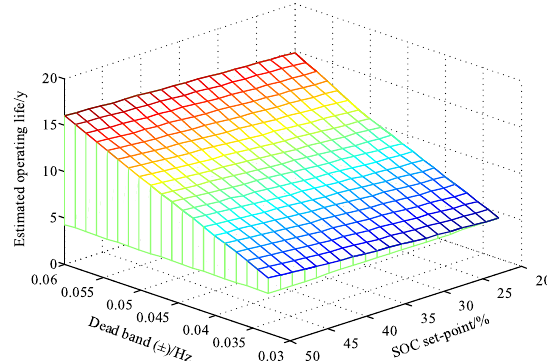
Fig. 8 The estimated operating life of the ESS under different SOC set-points and different frequency regulation dead bands